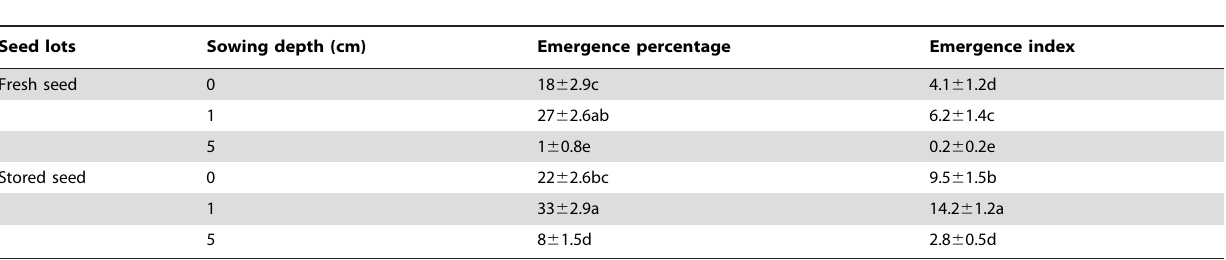
Table 2. Seedling emergence percentages and index for fresh one-year-stored seeds of Stipa bungeana at sowing depths of 0, 1 and 5